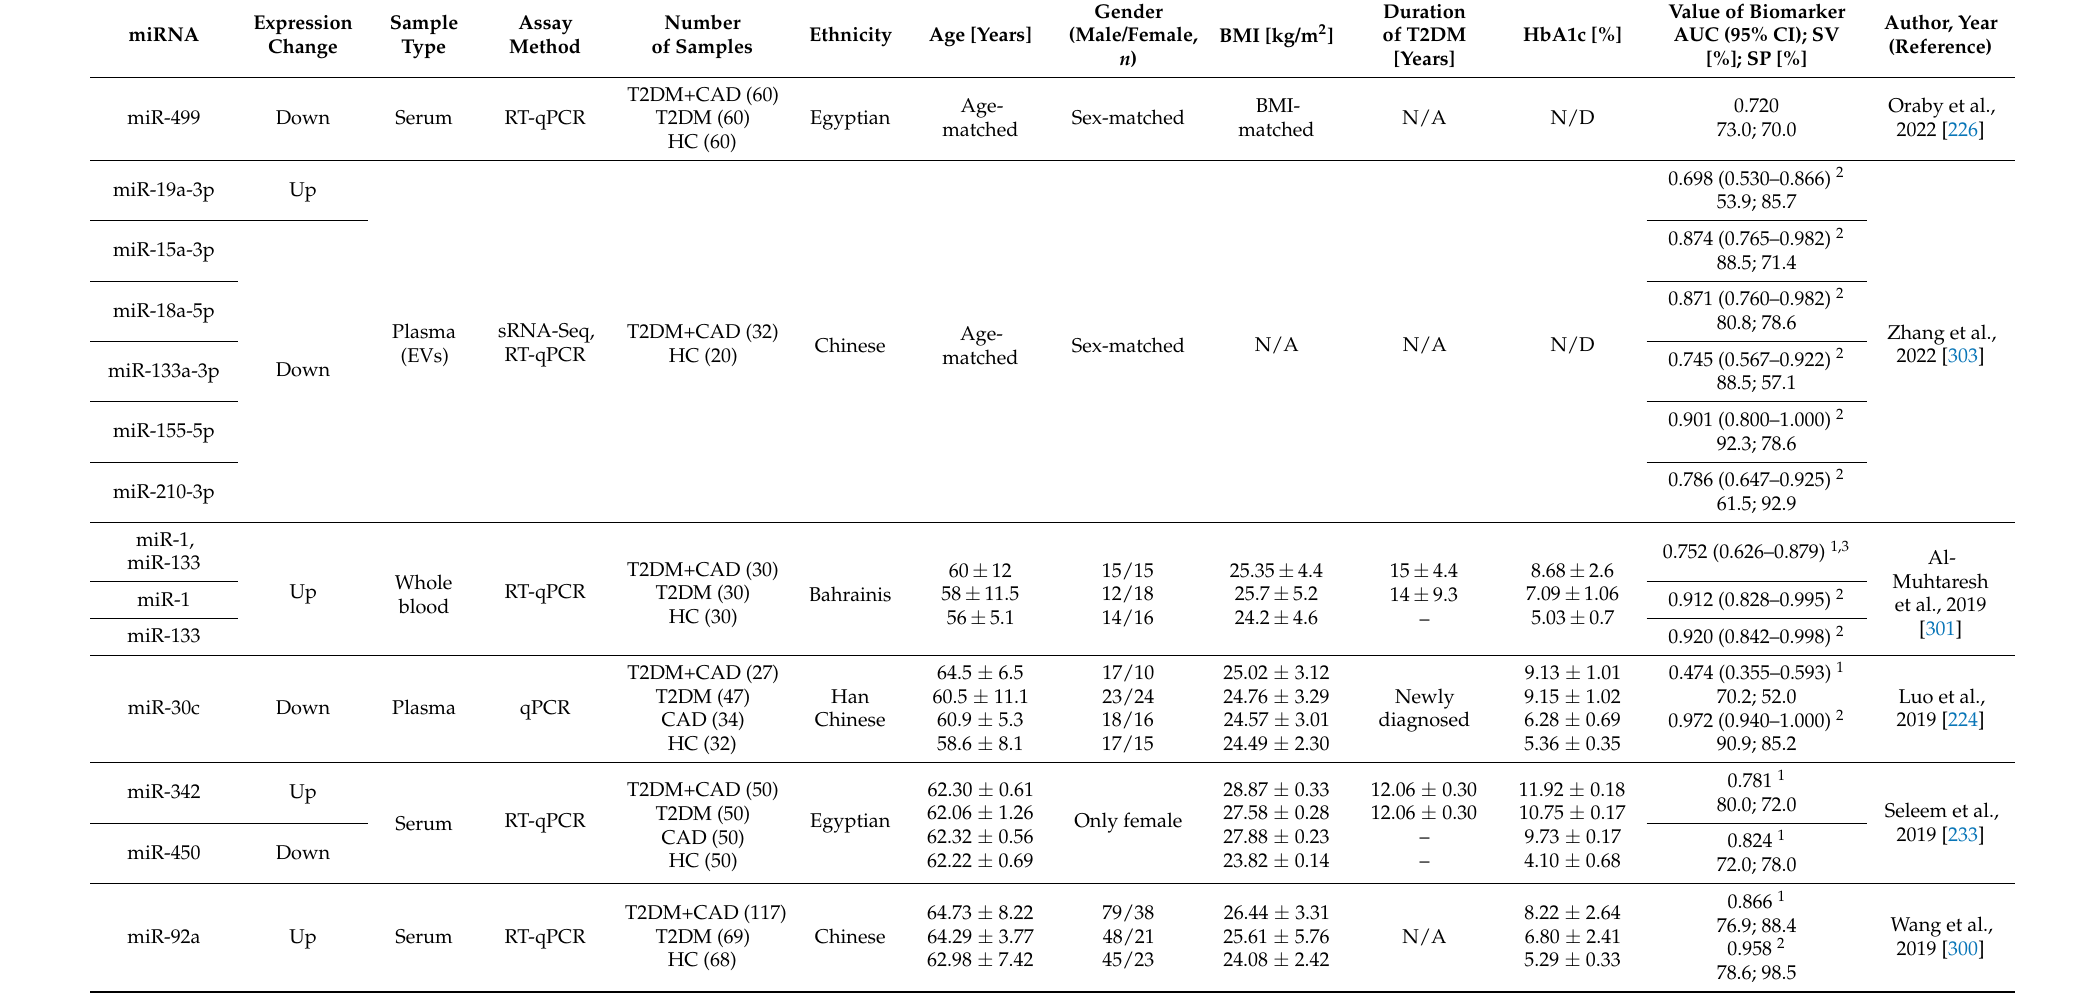
Table 3. Circulating microRNAs as potential biomarkers for stable coronary artery disease related to type 2 diabetes